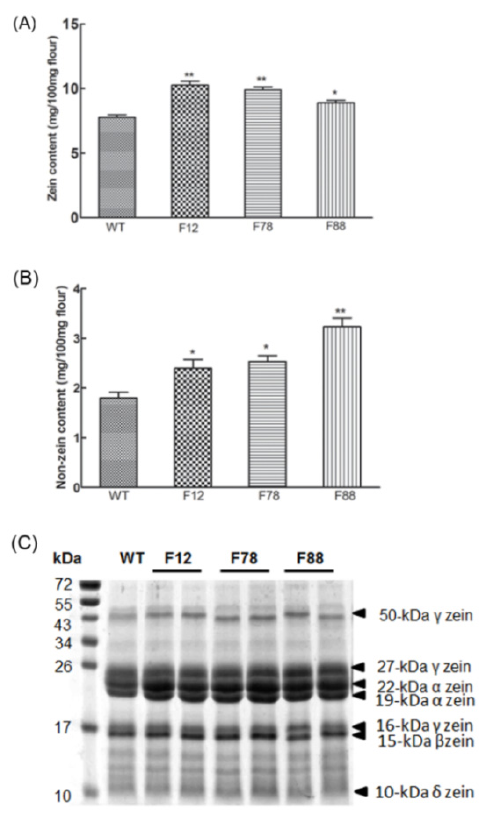
Figure 4. Zein and non-zein accumulation pattern in T kernels of three transgenic lines. 2 ( A ) Zein content; ( B ) non-zein content. All the calculations were performed with technical triplicates and biological triplicates, and 20 mature kernels were used per assay. The Student’s t- test is used to evaluate the difference between the transgenic maize and WT (* p < 0.05; ** p < 0.01); ( C ) Zein proteins of WT, F12, F78 and F88 lines were analyzed by SDS-PAGE. For SDS-PAGE, 5 μ L samples taken from the same amount of mature kernel flour were loaded to 15% polyacrylamide gel. The size for each protein marker and sample band was indicated by the numbers in the “kDa”